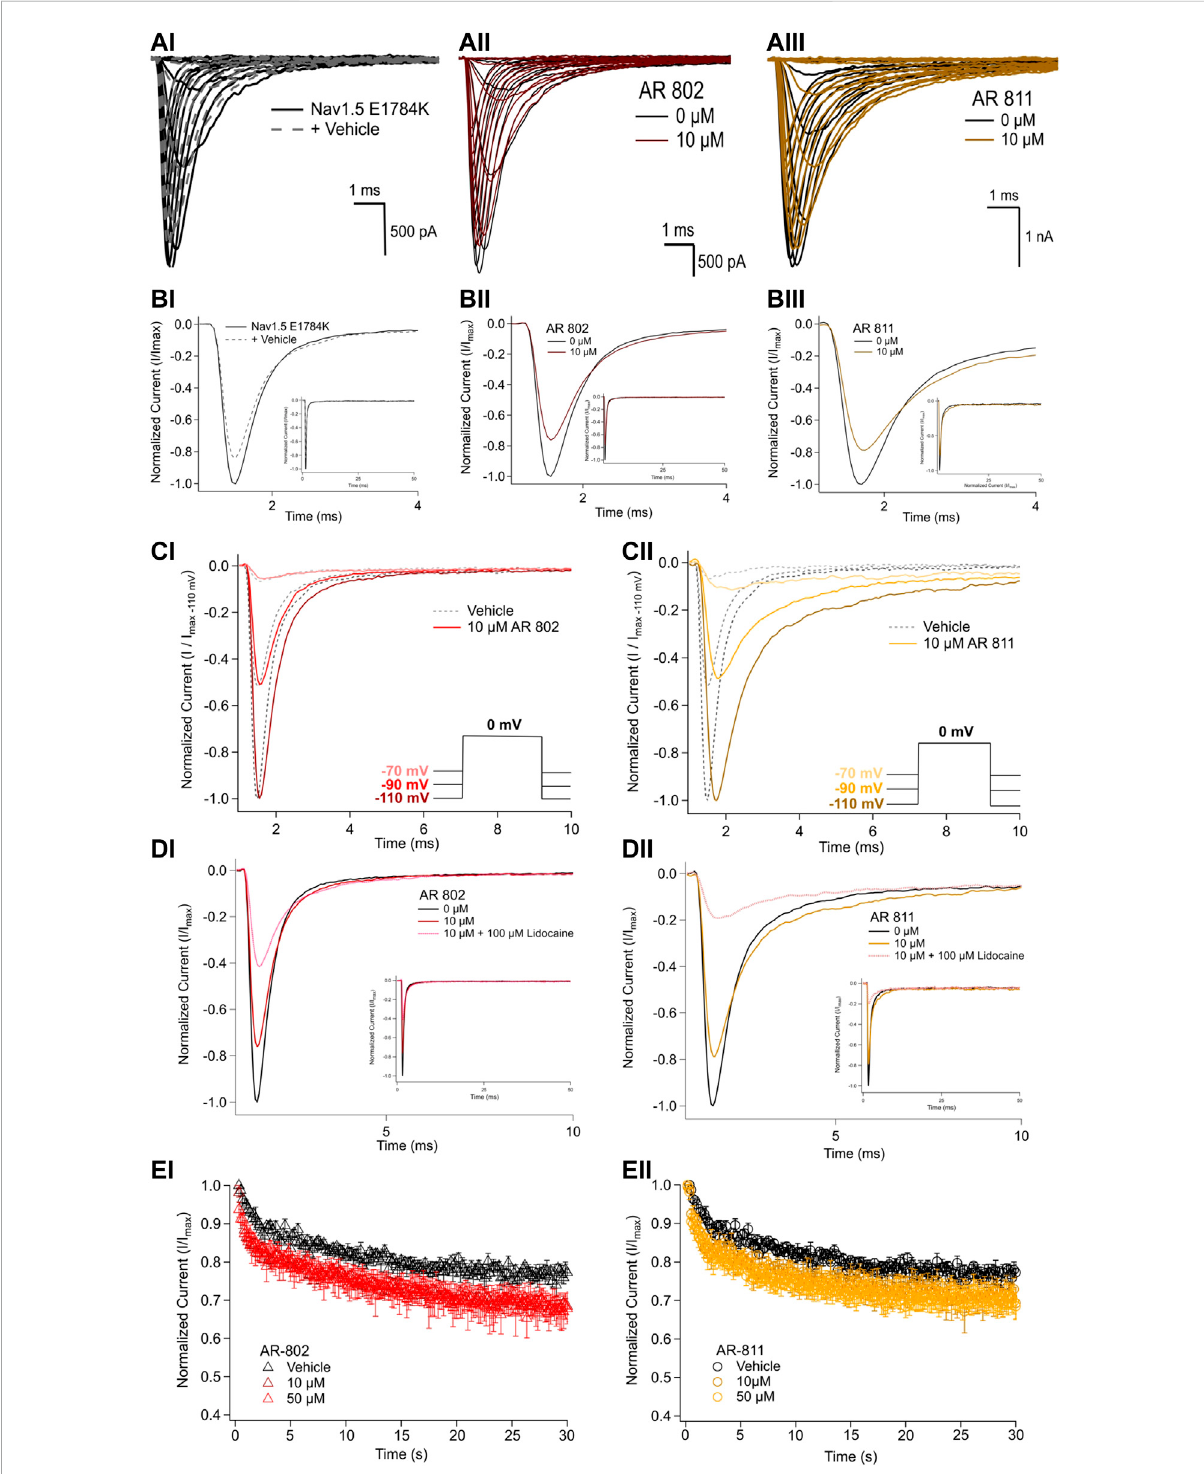
FIGURE 6 Effects of AR-802 and AR-811 on E1784K. (AI-III) show representative traces for peak I Na in vehicle (black) and compound treatment (varied colors, 10 µM) in E1784K. (BI-III) show representative traces emphasizing the deceleration in fast inactivation onset kinetics caused by AR-802 and AR-811 compared to vehicle. AR-802 and AR-811 had no signi fi cant effect on peak and persistent I Na as shown in the insets. (CI-CII) show the deceleration effect of AR-802 and AR-811 on fast inactivation onset when peak I Na is measured after pre-conditioning channels at − 110 mV, − 90 mV, and − 70 mV for 1 s as described in the Methods . (DI-DII) show the effects of both compounds with the application of 100 µM lidocaine. (EI-EII) show the effects of AR-802 and AR-811 on